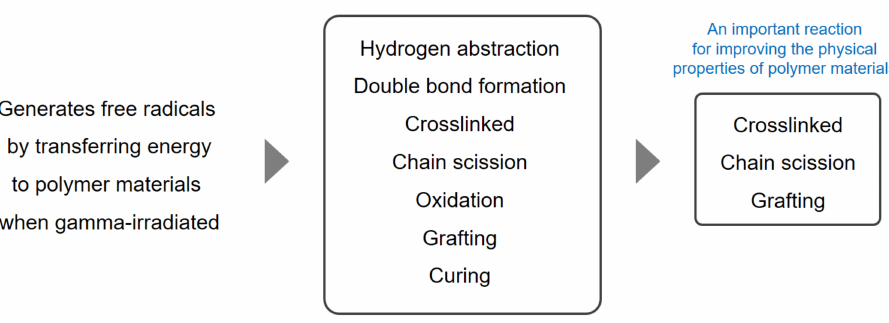
Figure 3. Various chemical reactions of polymer materials by gamma